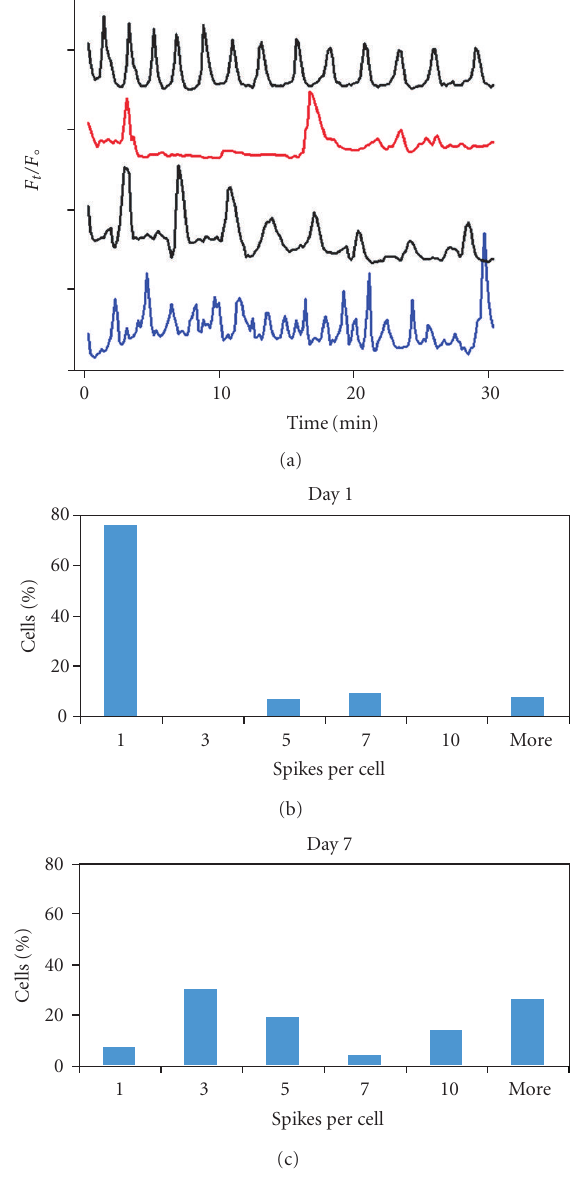
Figure 2: Typical temporal profiles of [Ca 2+ ] i oscillation observed in human MSC neurodi ff erentiation. The cell-type dependent characteristics of the [Ca 2+ ] i oscillations are displayed (a). The undi ff erentiated human MSCs show a pattern of regular [Ca 2+ ] i oscillation (top trace). The [Ca 2+ ] i oscillations become suppressed and irregular in time for human MSCs undergoing osteodi ff eren- tiation (second trace; at week 3). For comparison, we monitored the [Ca 2+ ] i oscillation in primary myocytes (third trace). The human MSCs undergoing neurodi ff erentiation, however, show yet another pattern of the [Ca 2+ ] i oscillation (bottom trace; at day 5) that resemble neither the undi ff erentiated human MSCs nor other cell types. Further, the [Ca 2+ ] i oscillation profiles of myocytes and neuronal cells could be distinguished. Unlike the undi ff erentiated human MSCs, the neurogenic cells exhibit multiple [Ca 2+ ] i oscillations and spikes whose amplitudes vary substantially. The two panels (b) and (c) show the distribution of the Ca 2+ spikes measured at the day 1 and 7 of MSC neurodi ff erentiation,